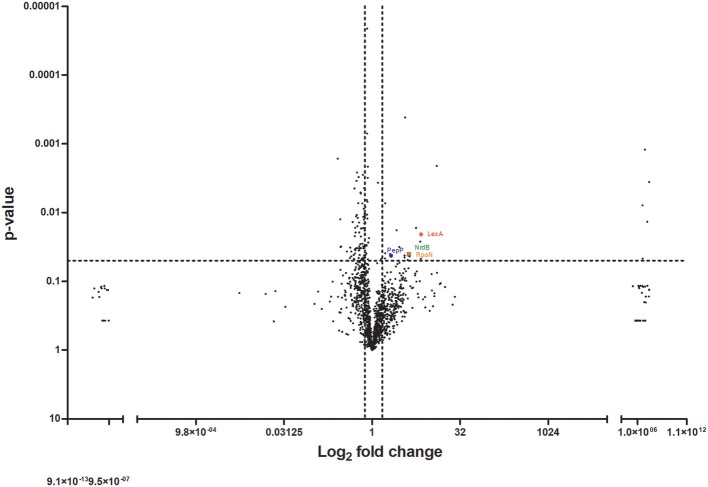
Proteomic analysis of the cell-free supernatant of a pair of peripheral and bloodstream P. aeruginosa isolates by mass spectrometry. Volcano plot demonstrating differentially abundant proteins detected and identified from bloodstream and peripheral isolate of Pair 2 (Table 1). Dotted line(s) through y-axis at cut-off for significance at p = 0.05, and through x-axis at +/− 1.5-fold change in protein abundance. Proteins identified and quantified following concentration with 3 kDa +/− filters. Significance determined by 1.5-fold difference in abundance with p ≤ 0.05 by paired two-tailed t-test.